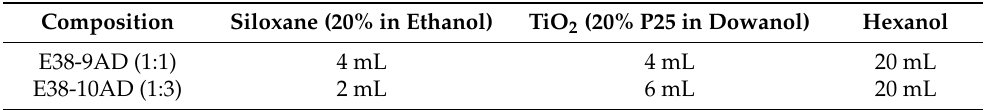
Table 3. Compositions designed for material